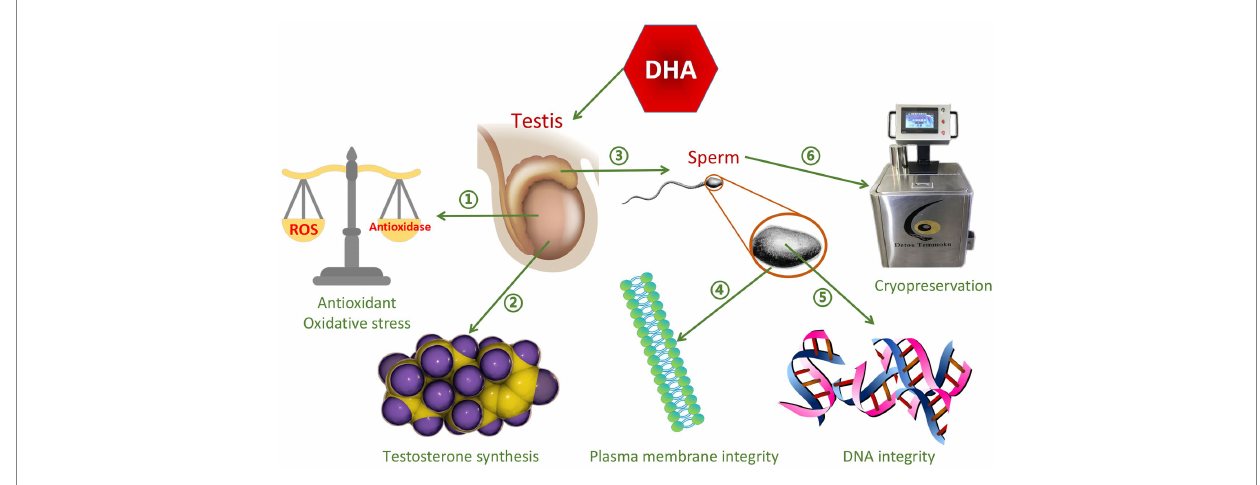
FIGURE 2 The function of DHA on semen quality. ➀ Improve antioxidant capacity and reduce oxidative stress ② Promote testosterone synthesis ③ Promote sperm maturation ④ Improve sperm plasma membrane integrity ➄ Improve DNA integrity ⑥ Protect sperm from damage caused by